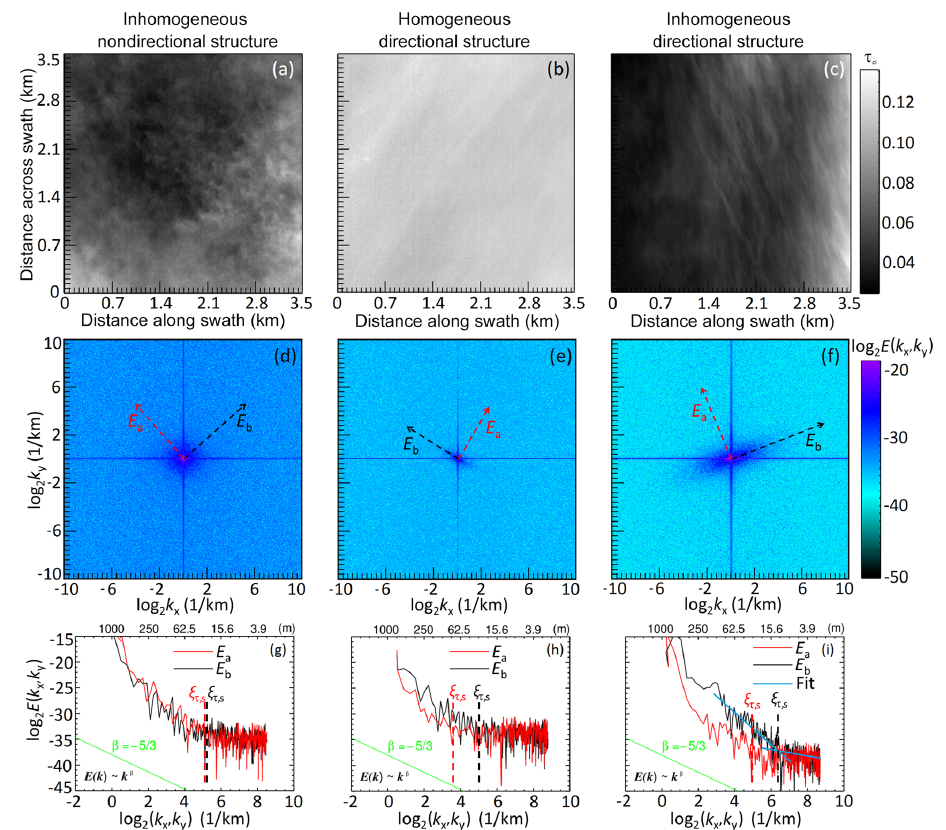
Figure 5. (a–c) AisaEAGLE image (3.5km by 3.5km), (d–f) 2-D power spectral density E(k x ,k y ) , and (g–i) 1-D power spectral density E(k x ,k y ) across (red arrows, E a ) and along (black arrows, E b ) the prevailing direction of scale-invariant areas for (a, d, g) inhomogeneous cloud without directional structure, (b, e, h) homogeneous cloud with slight directional structure, and (c, f, i) inhomogeneous cloud with distinct directional structure. The ξ τ, s are marked by dashed coloured